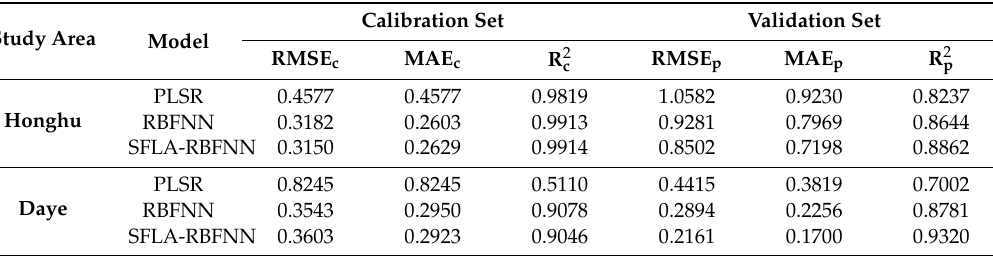
Table 4. Prediction accuracies based on sCARS-SPA.